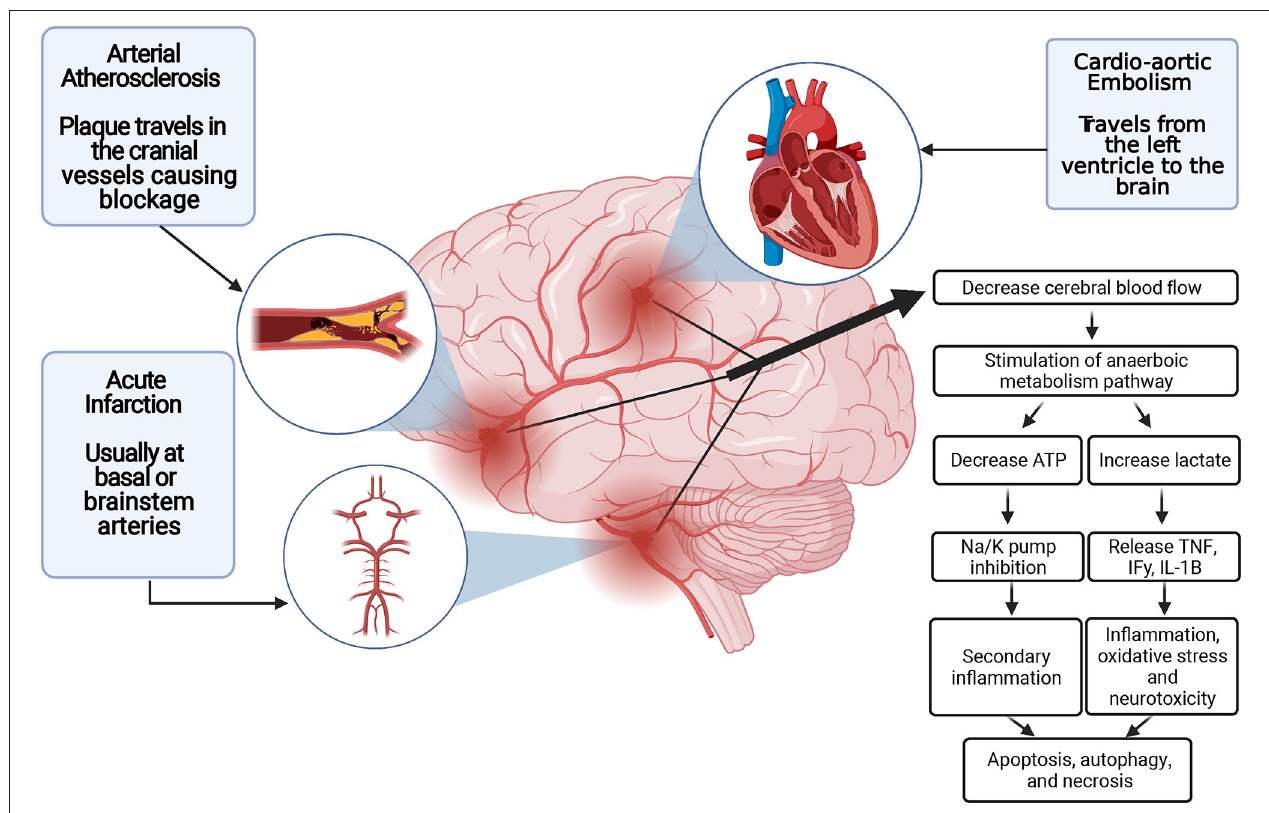
FIGURE 1 | Blood supply disruption and ischemic stroke pathogenesis. ATP indicates adenosine triphosphatase; IF γ , Interferon gamma; IL-1B, interleukin 1B; K, potassium; Na, sodium; TNF α , tumor necrosis factor α